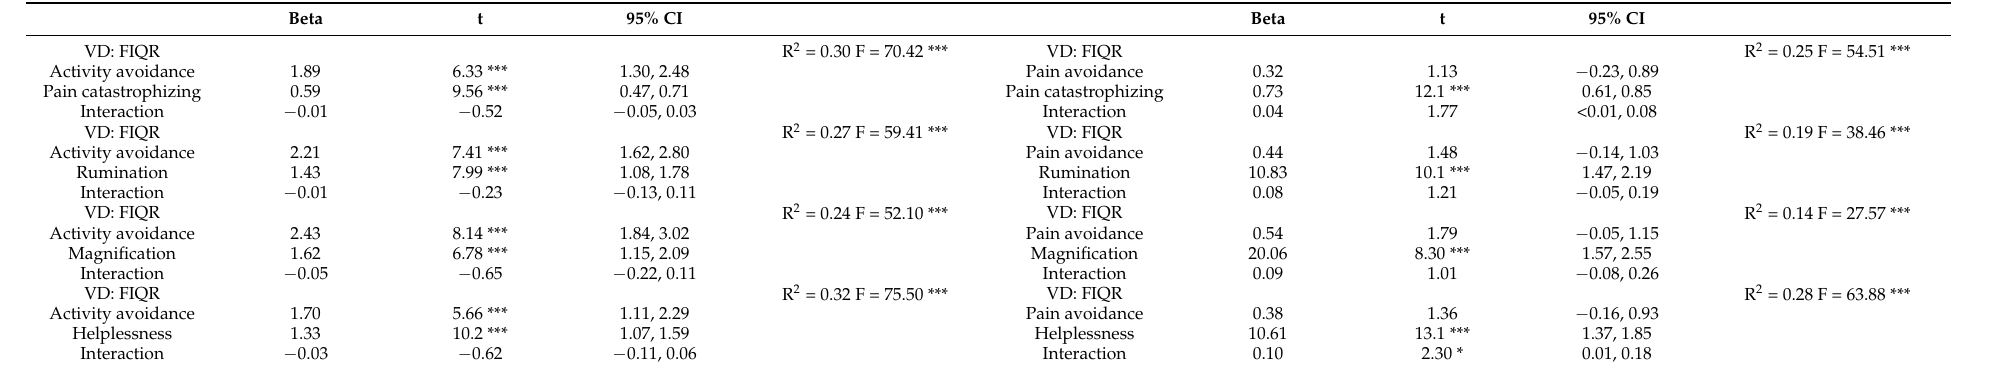
Table 3. Prediction of fibromyalgia impact from activity avoidance, pain avoidance, pain catastrophizing (total score and dimensions), and their